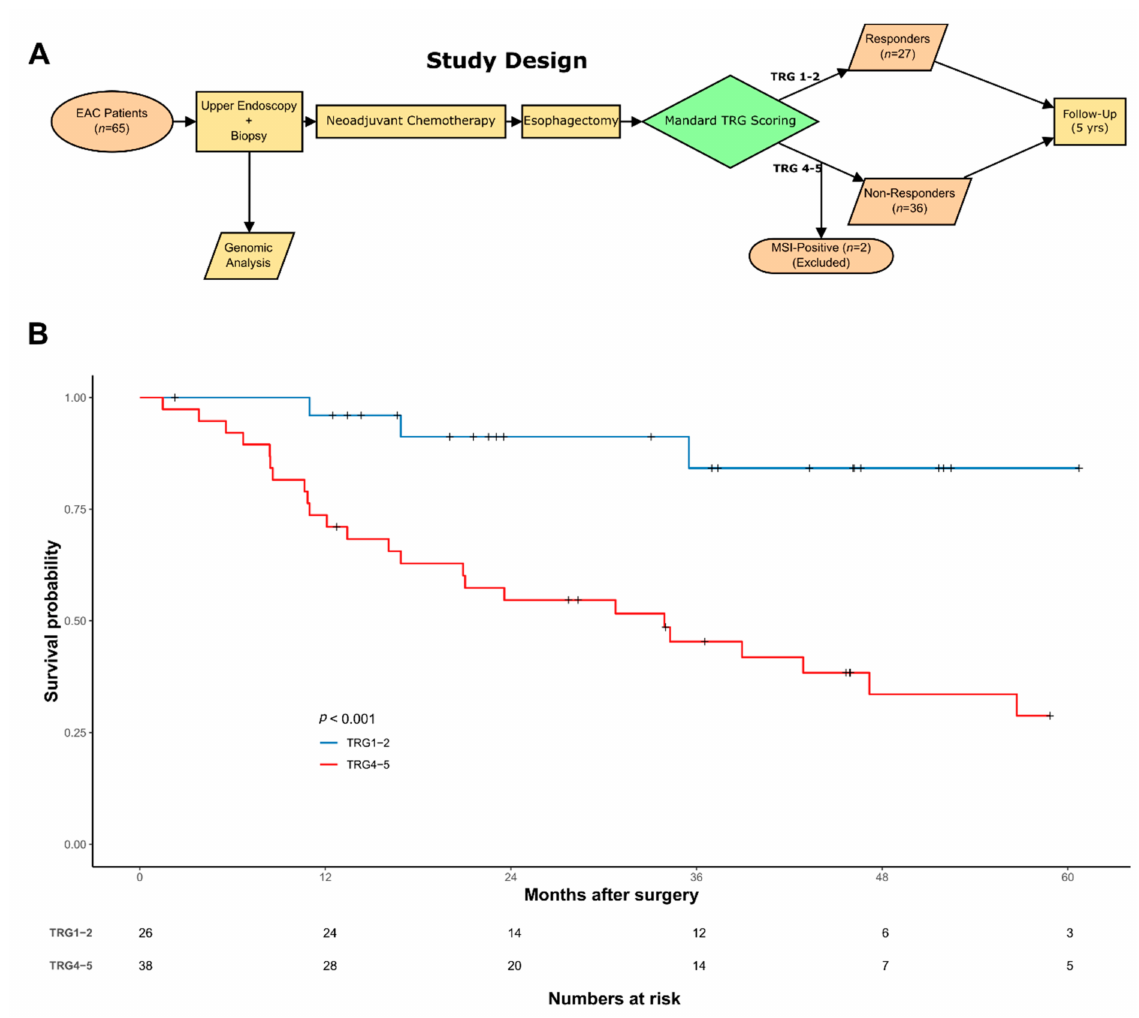
Figure 1. Outline of the cohort and analyses performed. ( A ) Description of the study design. ( B ) Kaplan–Meier of overall survival ( n = 64) for responders (blue line) and non-responders (red line). Number of cases at risk are detailed in the